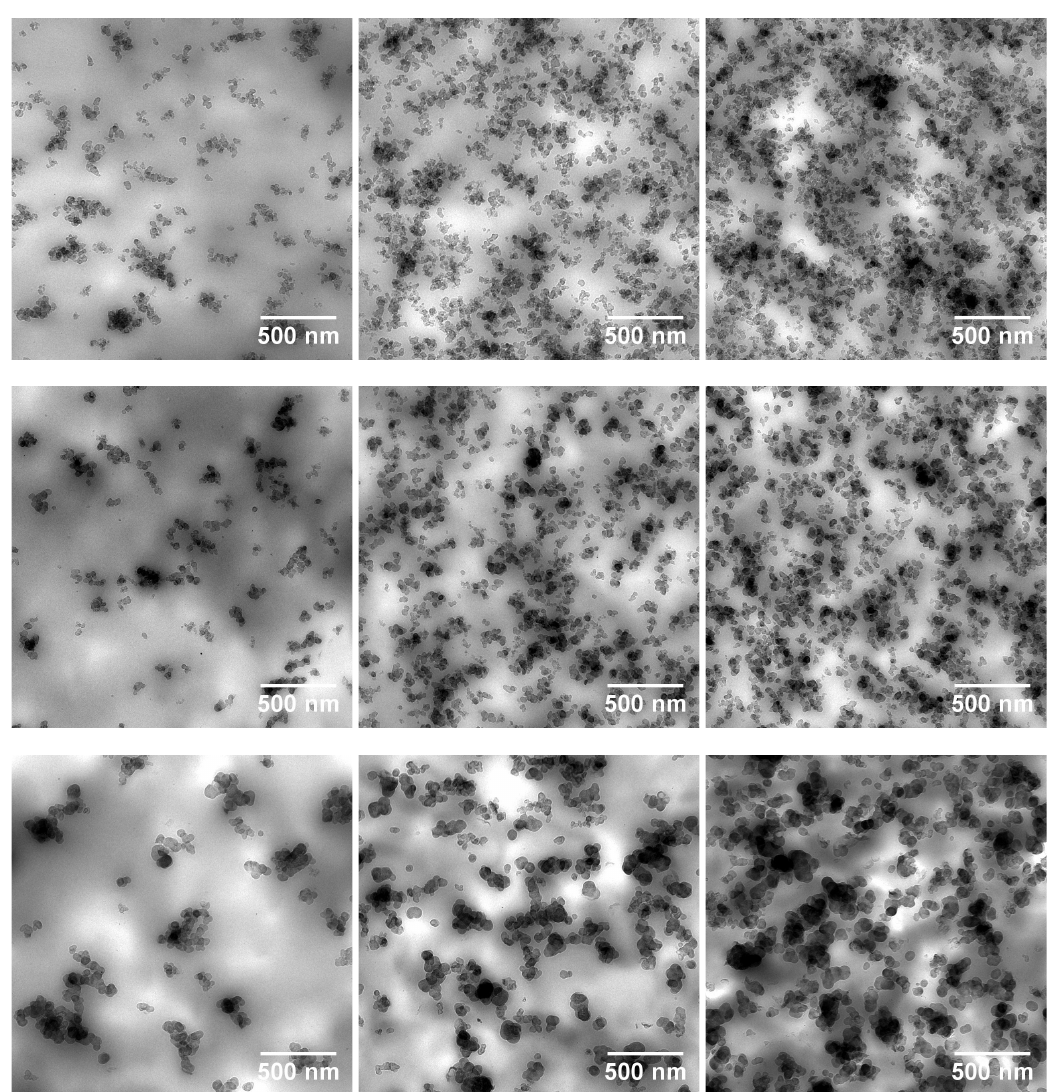
Figure 5. TEM images for N121 ( top row ), N339 ( middle row ), and N550 ( bottom row ) in SSBR compounds with filler concentrations below, around, and above percolation